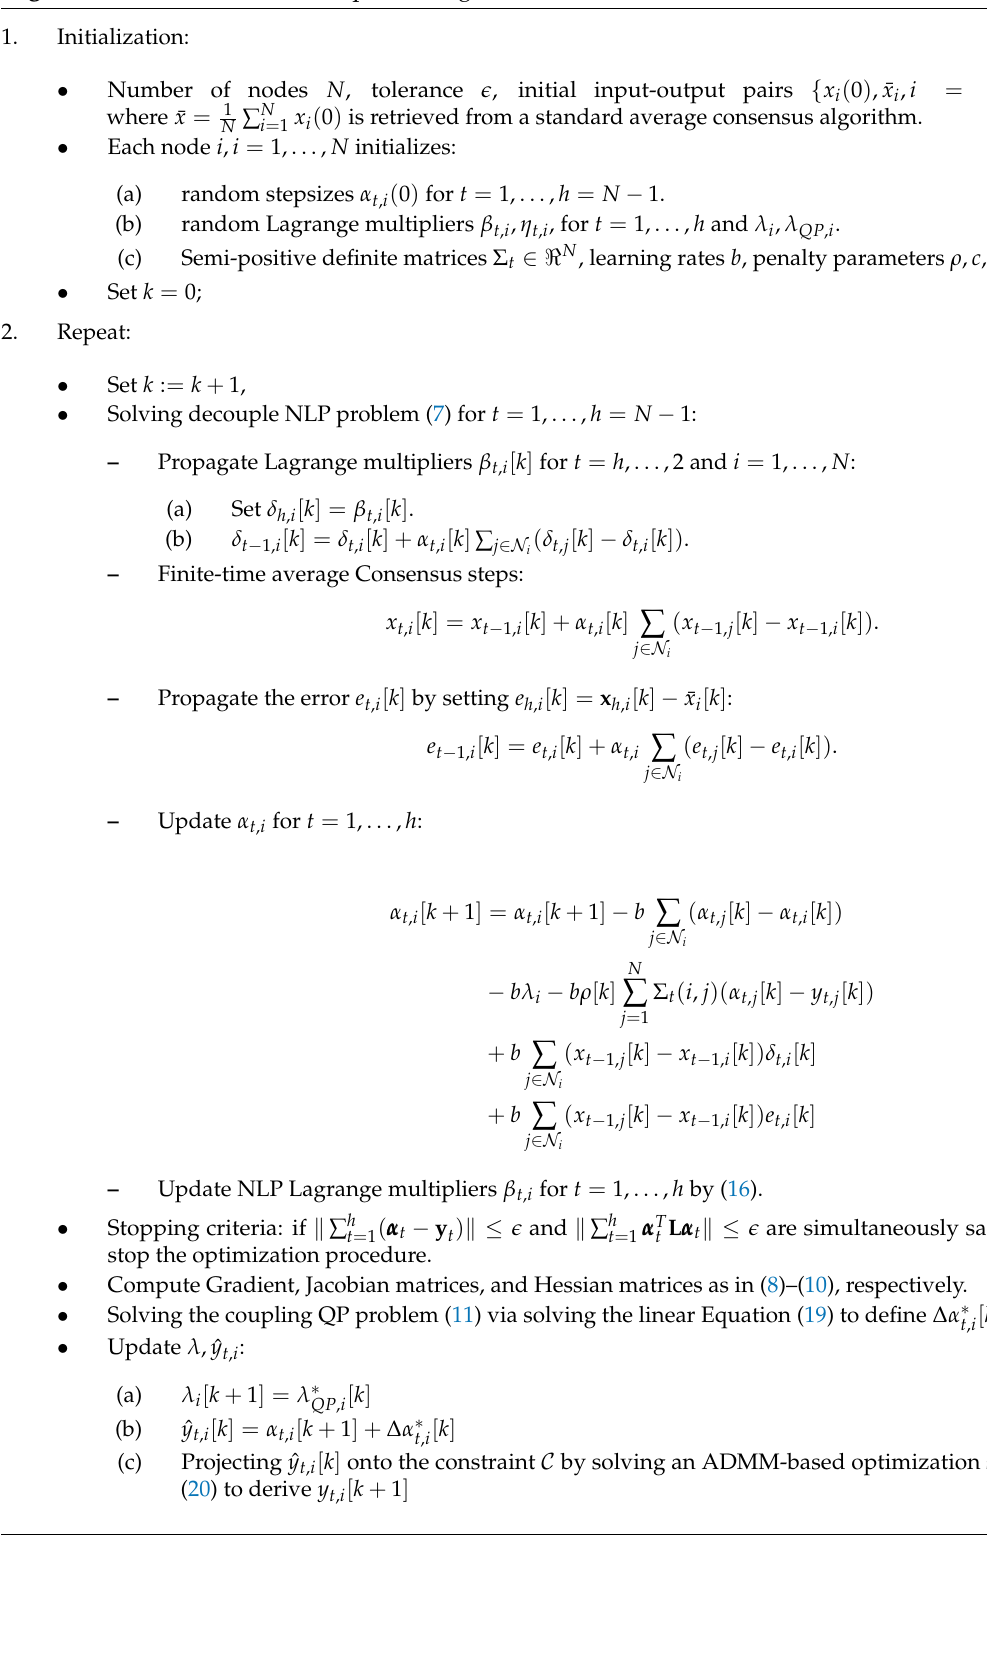
Algorithm 1 ALADIN-based Laplacian eigenvalues